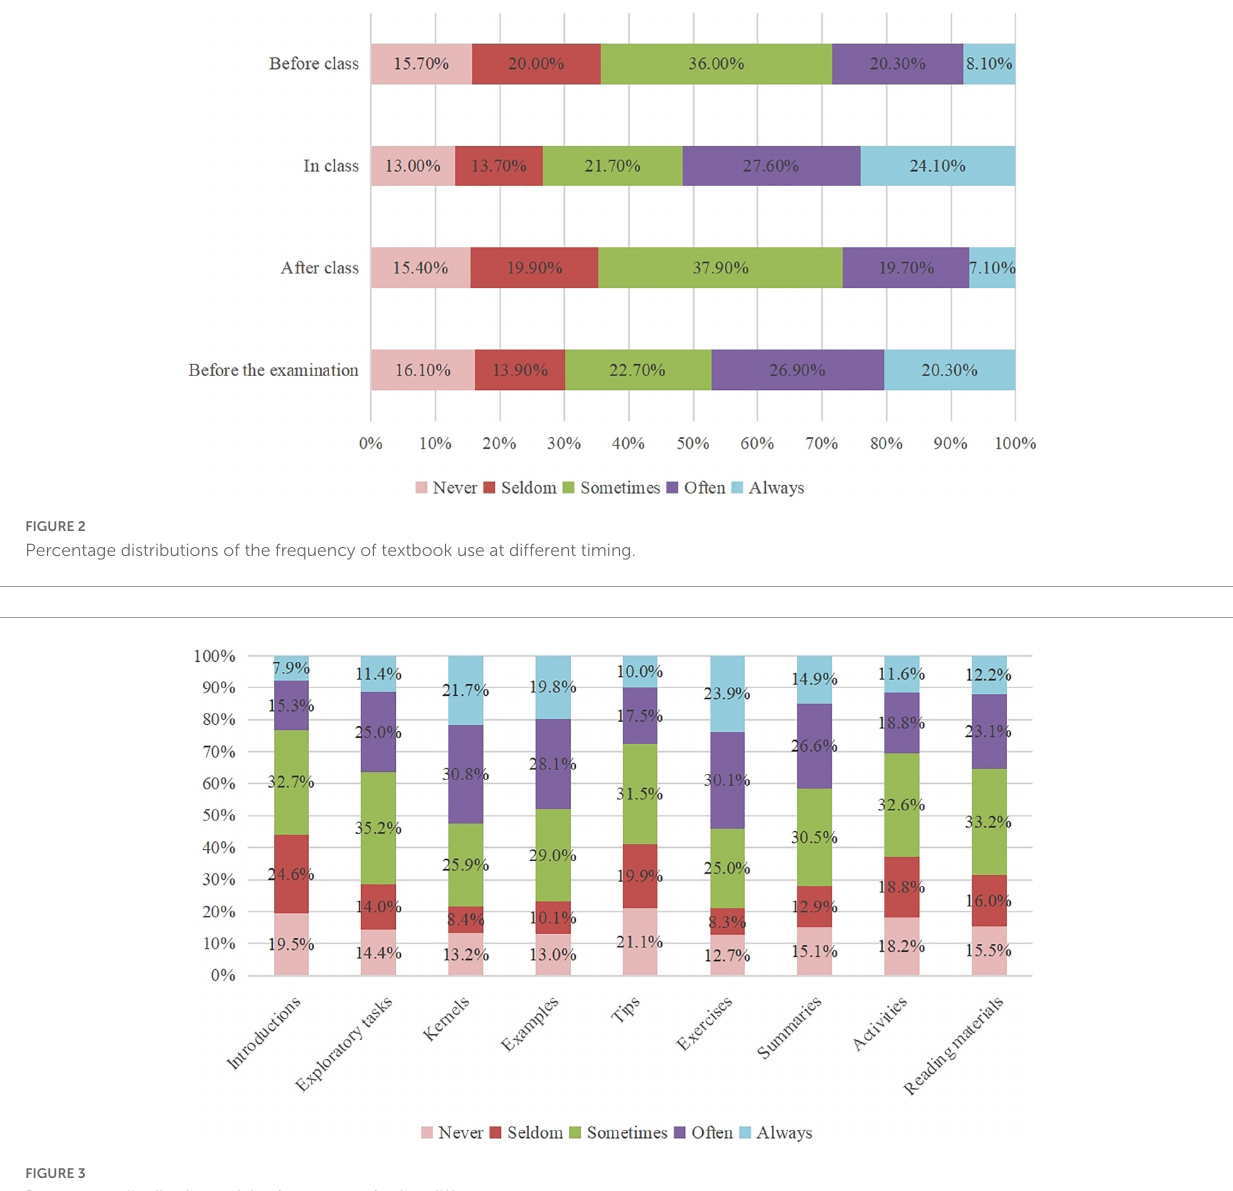
FIGURE3 Percentage distributions of the frequency of using different